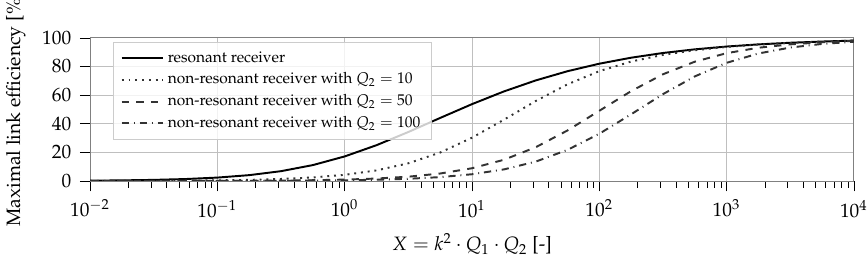
Figure 6. The maximal efficiency for a series resonant compared to a non-resonant secondary circuit as a function of the coil quality factors and the coupling factor with a = a max [6].